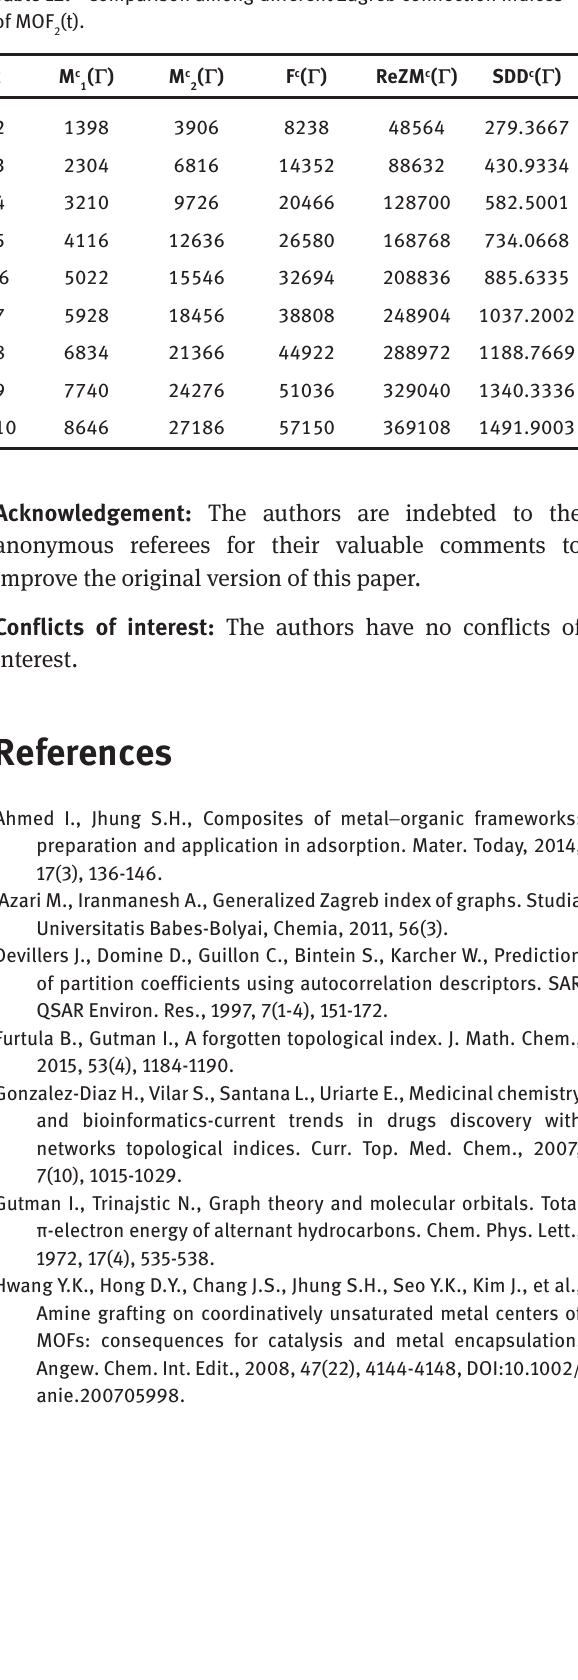
Zagreb connection indices are better than Zagreb indices.